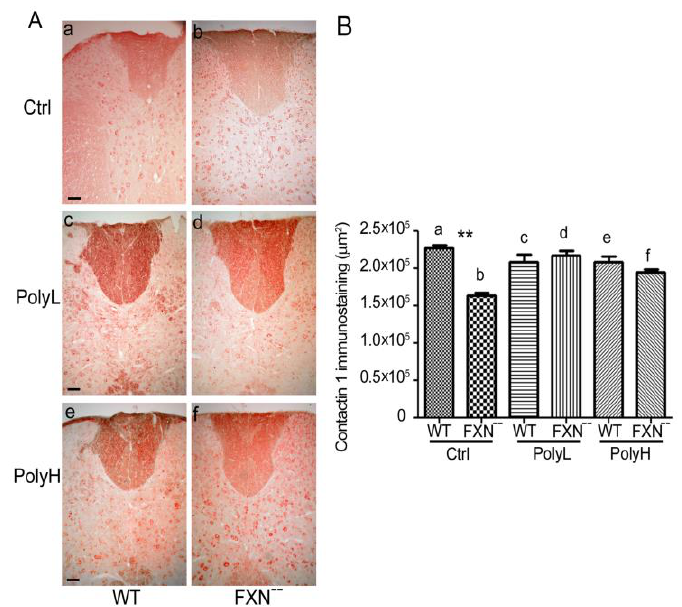
Figure 6. ( A ): Expression of Contactin 1 in the dorsal funiculus from WT (a,c,e) and FXN – mutant (b,d,f) mice in the absence (Ctrl, a,b) or in the presence of polyphenol (EGCG) administration under the low (PolyL; 0.0185 mg / g, c,d) or the high (PolyH; 0.185 mg / g, e,f) concentration protocols. Scale bar: 100 µ m. ( B ): Results of the morphometric analysis of Contactin 1 immunostaining in the conditions reported in ( A ), expressed as pixels / field. Note the significant reduction of Contactin 1 expression in FXN – mutant mice in control conditions (a,b) and its recovery in the presence of EGCG polyphenol administration (both PolyL, c,d and PolyH, e,f concentration protocols). A p -value of 0.001, indicated by **, was considered statistically significant.